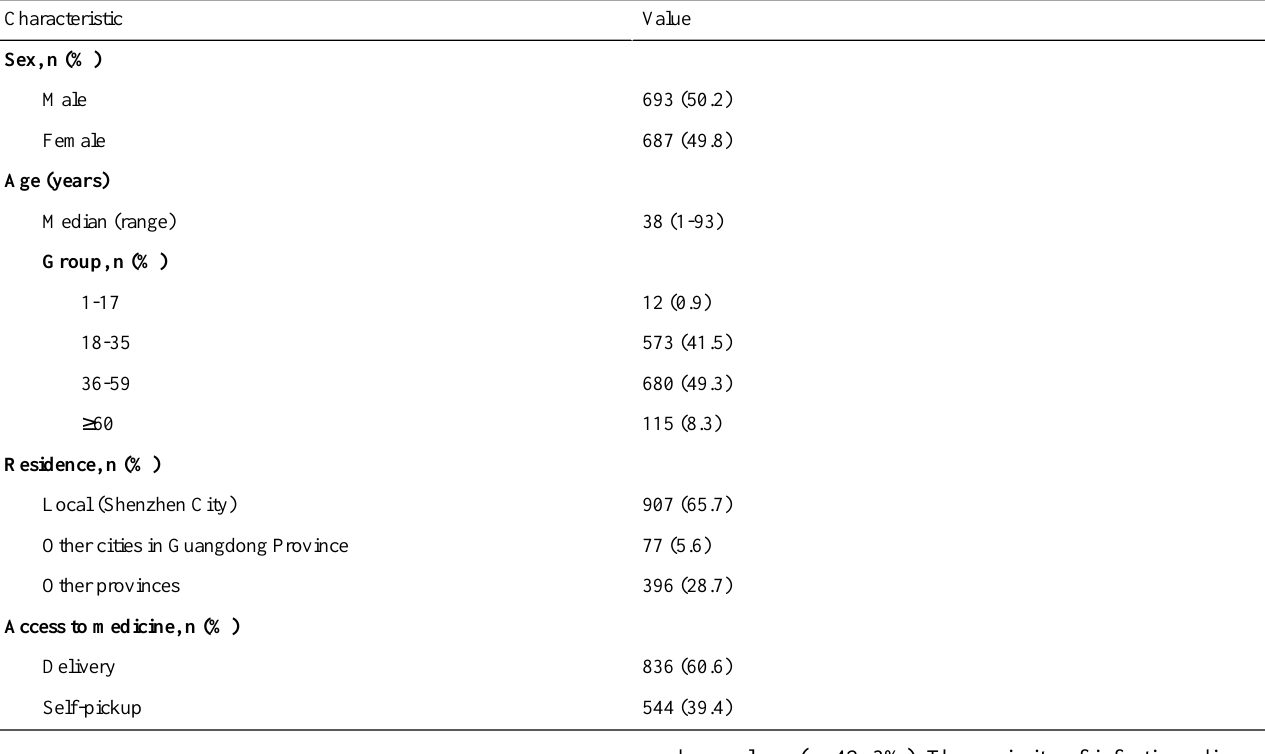
Table 1. Baseline characteristics of patients (N=1380).